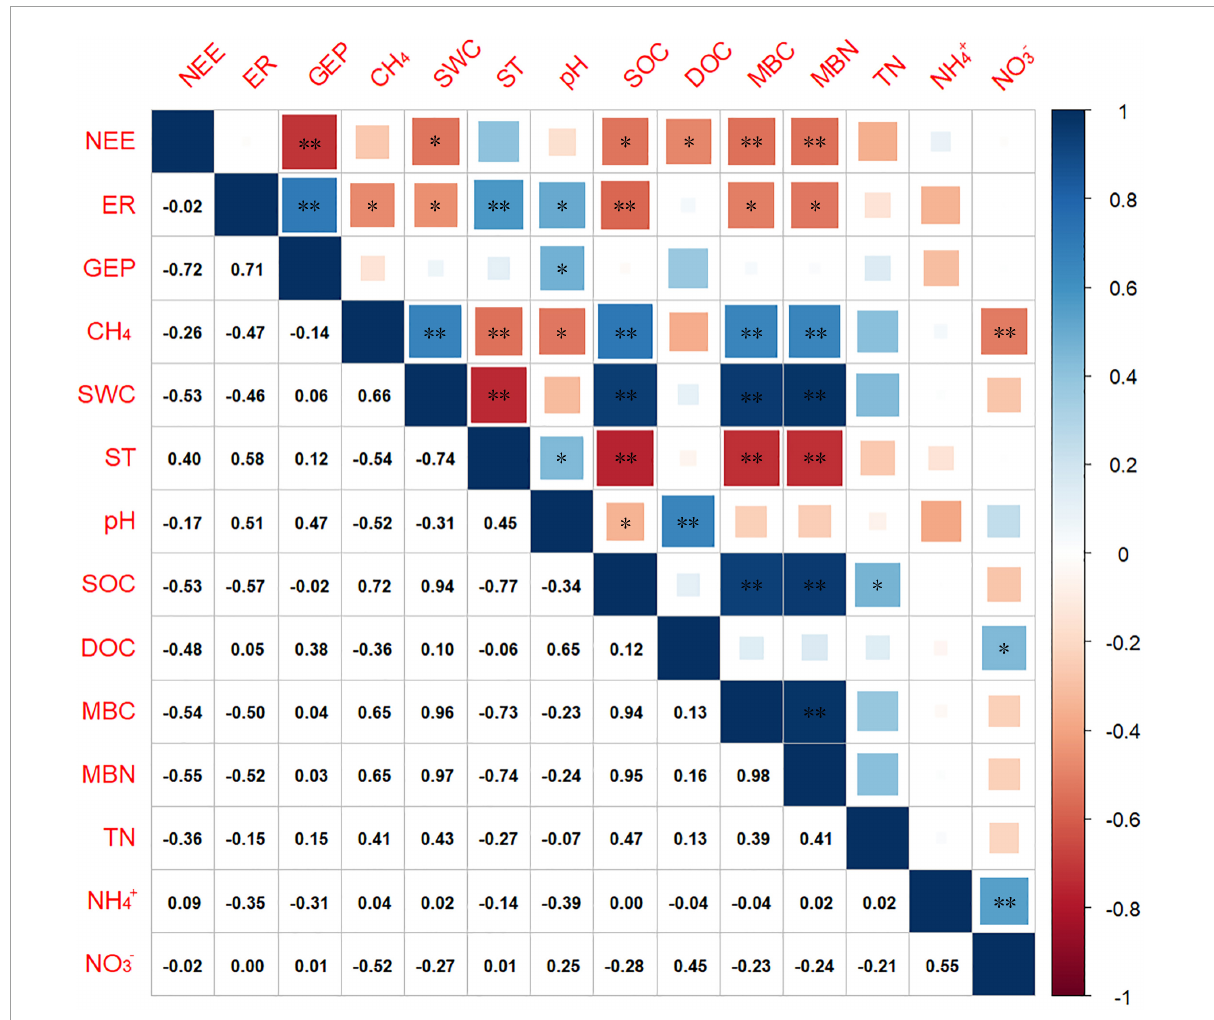
FIGURE4 Heatmap of the correlations between NEE, ER, GEP, and CH 4 and the environmental factors. A blue square indicates that the correlation coefficient is positive, and a red circle indicates that the correlation coefficient is negative. The correlation coefficient decreased as the color became lighter and the size became smaller. NEE, net ecosystem CO 2 exchange; ER, ecosystem respiration; CH 4 flux, methane flux; SWC, soil water content; ST, soil temperature at the 5 cm depth; SOC, soil organic carbon; DOC, dissolved organic carbon; MBC, microbial biomass carbon; MBN, microbial biomass nitrogen; TN, total nitrogen; NH 4 + , ammonia; NO 3 − , nitrate; “ ∗ ” and “ ∗∗ ” represent significant differences at the 0.01 and 0.001 levels,